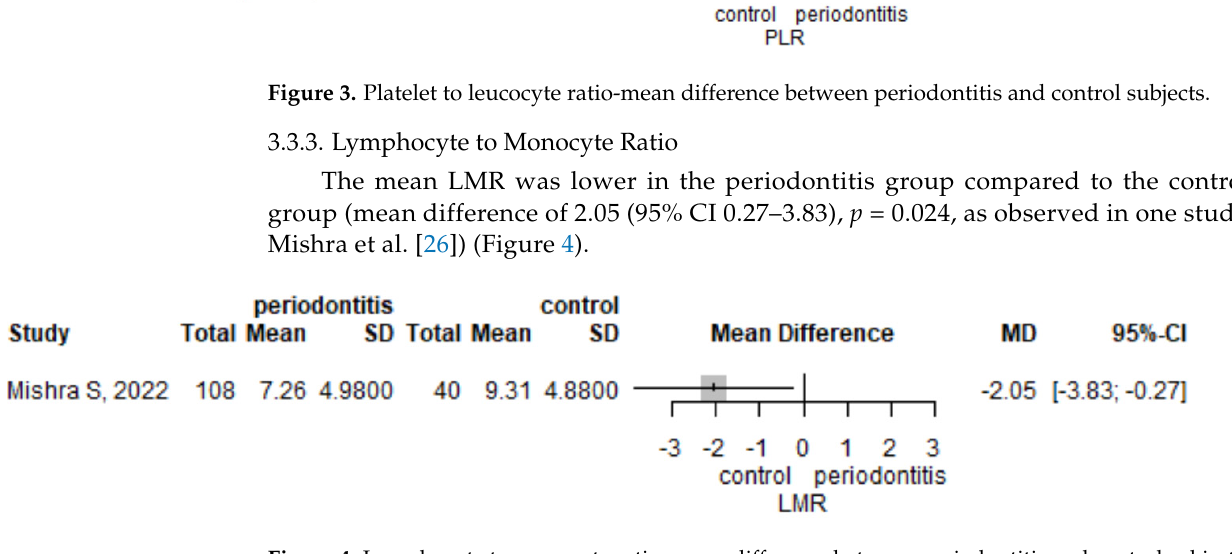
Figure 4. Lymphocyte to monocyte ratio -mean difference between periodontitis and control sub- jects.